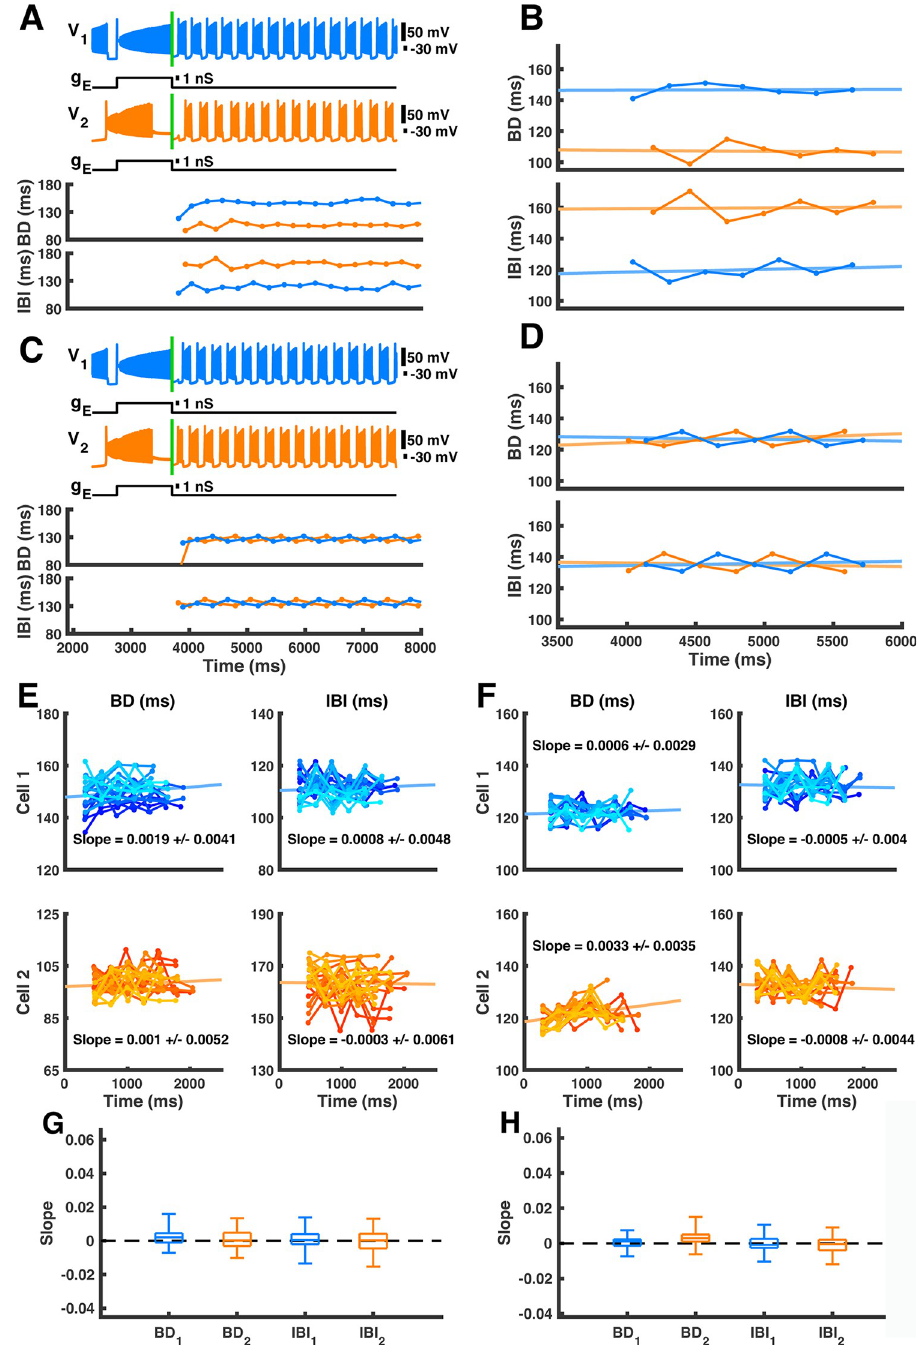
Fig 8. Constant h CaS during transient paw-shake-like activity. (A) h CaS was set constant in both neurons at pulse offset; this moment is marked by a vertical green line. The same example of transient activity that was used in Figs 1, 3, and 6 is shown. h CaS1 and h CaS2 were held constant at the values they had reached at that moment ( h CaS1 = 0.0311, h CaS2 = 0.0242). (B) BD and IBI are shown for the first few bursts of trace in A . These burst characteristics can be compared to Fig 3B or Fig 6B. (C) h CaS was again set constant at pulse offset (vertical green line), but in this case h CaS1 and h were both set to the average of the values they reached at the end of the pulse ( h = h = 0.0277). (D) CaS2 CaS1 CaS2 The progression of BD and IBI of trace shown in C . (E) h CaS was set constant asymmetrically after the pulse for all 286 transience cases used in Fig 5. Linear regression analysis was applied to the resulting progressions of BD and IBI and the mean linear curve fit is shown. (F) h was set constant symmetrically after the pulse for all 286 transient CaS